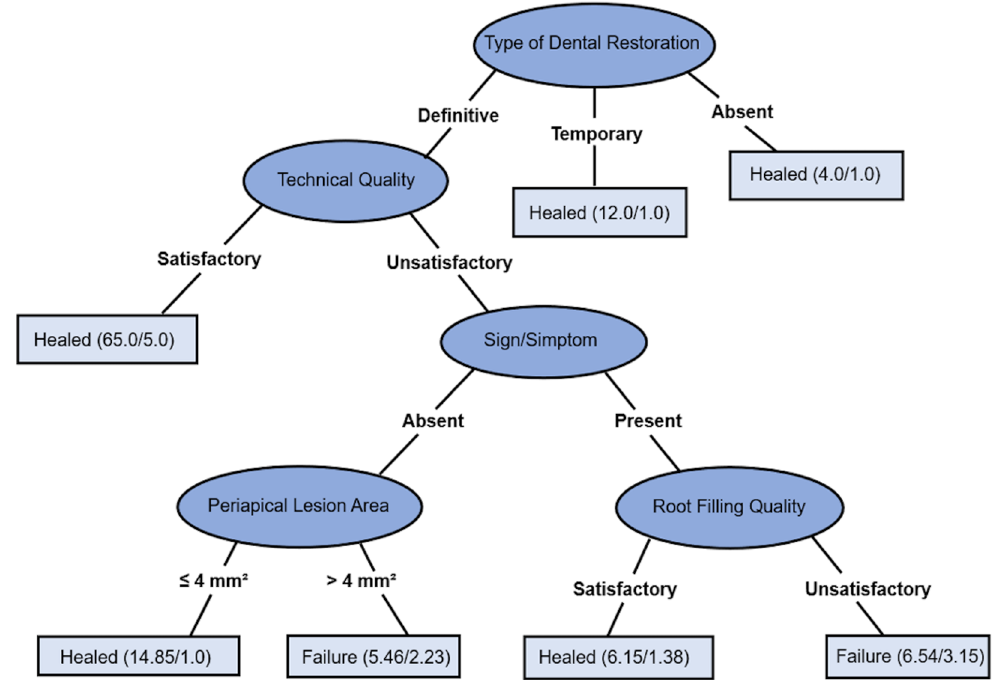
Figure 4- Decision tree C: Prediction of periapical healing of non-surgical root canal retreatment, including variables related to demographic data, medical history, diagnosis, endodontic retreatment characteristics, and follow-up data – (1) For absent coronal sealing or presence of temporary dental restoration at the time of follow-up visit, periapical healing was classified as healed. (2). For definitive dental restoration and satisfactory technical quality of endodontic retreatment, periapical healing was classified as healed. (3) For definitive dental restoration at the follow-up visit, unsatisfactory technical quality of endodontic retreatment, presence of signs/symptoms at the time of diagnosis, and unsatisfactory root fillings in the primary endodontic treatment, periapical healing was classified as failure to heal; but for satisfactory root filling quality of the primary endodontic treatment, periapical healing was classified as healed; (4) For identification of definitive dental restoration at the follow-up visit, unsatisfactory technical quality of endodontic retreatment, absent signs/symptoms, and periapical lesion area greater than 4 mm2 at the time of diagnosis, periapical healing was classified as failure to heal. However, for periapical lesion areas smaller than 4 mm2, periapical healing was classified as healed. The values in parentheses indicate the total number of correctly/ incorrectly classified instances in each leaf per node (Accuracy of